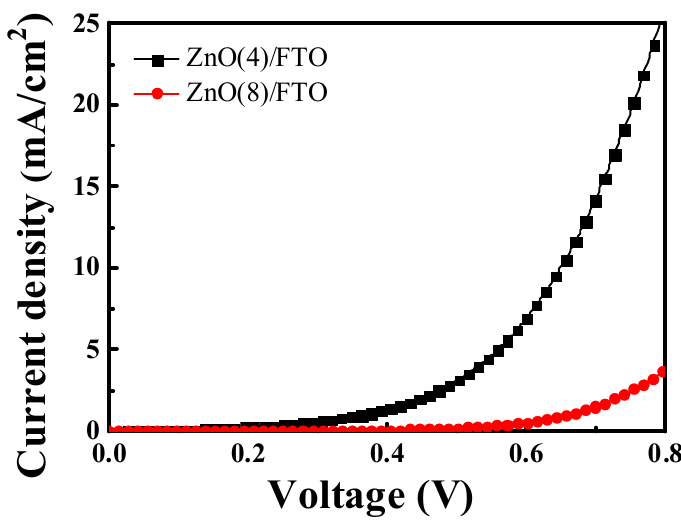
Figure 7. Dark current-voltage characteristics of DSSCs with ZnO(4) / FTO and ZnO(8) / FTO photoelectrodes. The J sc value of the ZnO(8) / FTO DSSC (1.577 mA / cm 2 ) is very similar to that of the